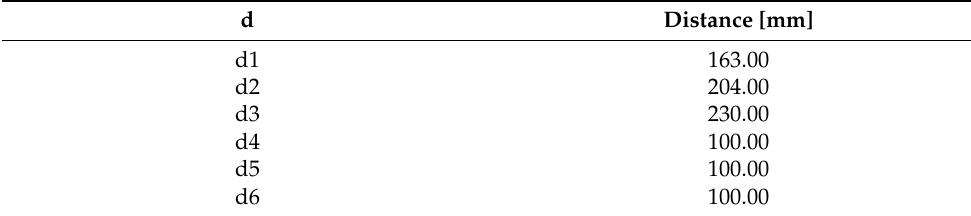
Figure 6. Kinematics of the robotic manipulator. Table 1. Distance values between links.